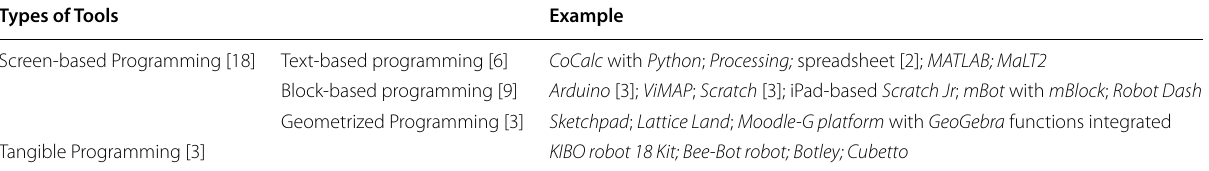
Note : [N] denotes total literature counts of each tool